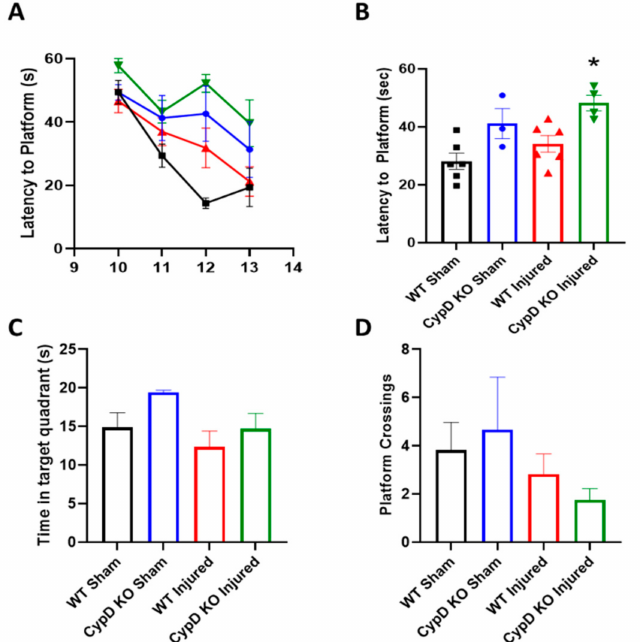
Figure 4. CypD knockout does not improve memory function following TBI. ( A ) Average learning progression, characterized by latency to platform, over days 10 to 13 after injury. ( B ) Morris water maze (MWM) latency to platform data collapsed across all training days. CypD knockout in injured animals resulted in an increase in latency to platform compared to WT Injured mice. * p = 0.033 vs. WT Injured. ( C ) At 14 d after TBI, mice performed the probe trial. Time in the target quadrant was calculated. ( D ) During the probe trial, the number of times mice crossed the platform area was also quantified. Data points represent group mean ± SEM. N = 3–6/group.